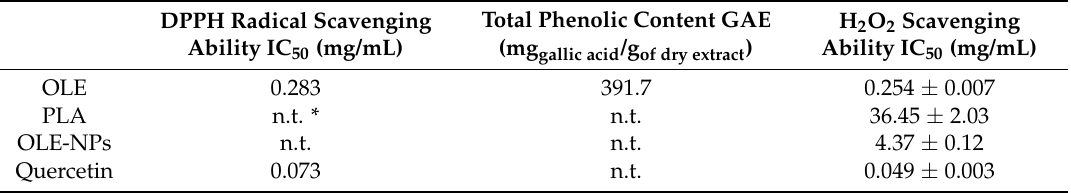
Table 1. Antioxidant activity of olive leaves extract (OLE), poly(lactic acid) (PLA) and OLE-loaded nanoparticles (OLE-NPs). Quercetin was used as a reference antioxidant.